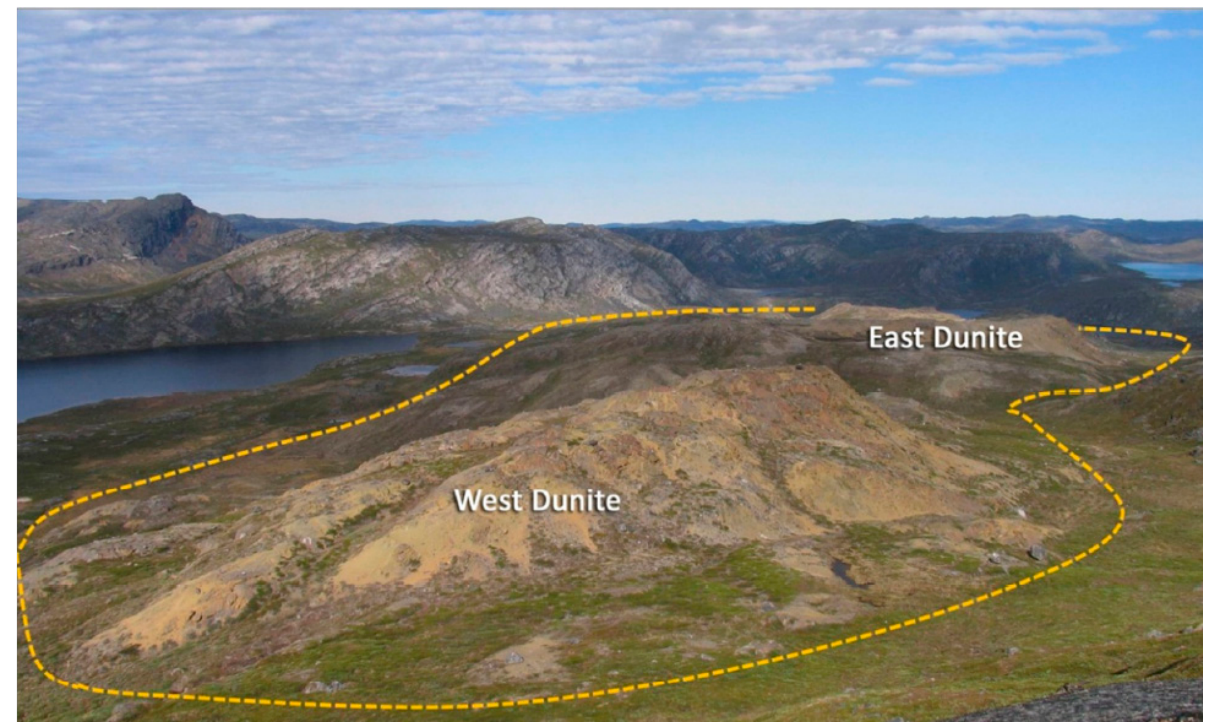
Figure 2. The Niaqornarssuit complex from the southwest. The dashed lines outline the complex of 2 × 1 km size [37] .